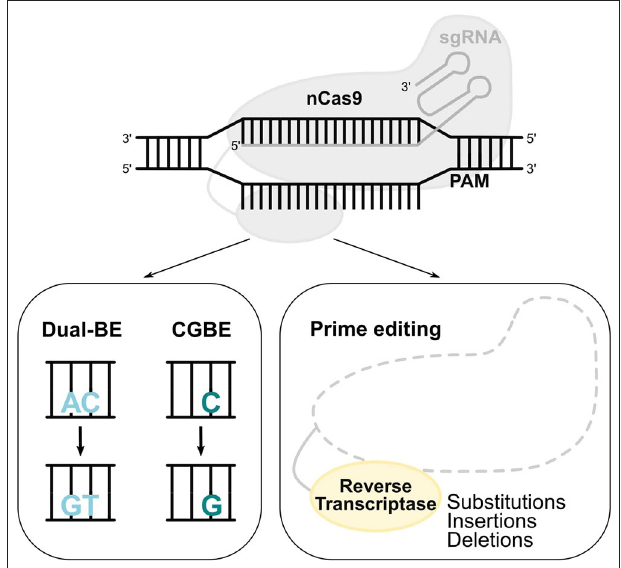
FIGURE 4 | Novel base and prime editors. Novel BEs with a modified deaminase, such as dual functioned BE and CGBE, convert AC-to-GT or CA-to-TG, and C-to-G, respectively. In the prime editing system, a reverse transcriptase uses a pegRNA to install substitutions, insertions, and